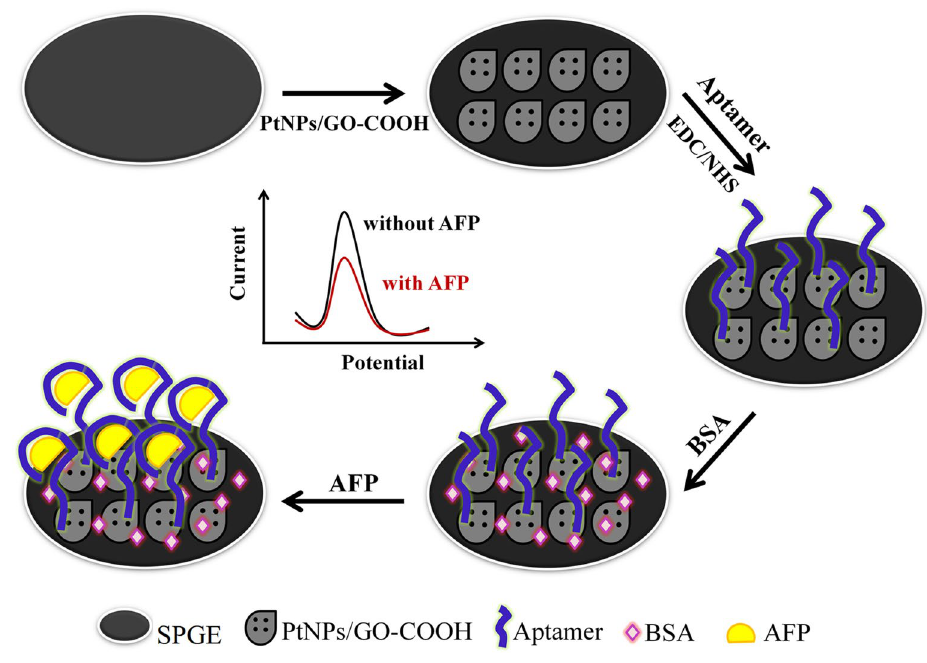
Figure 1. The stepwise preparation of the